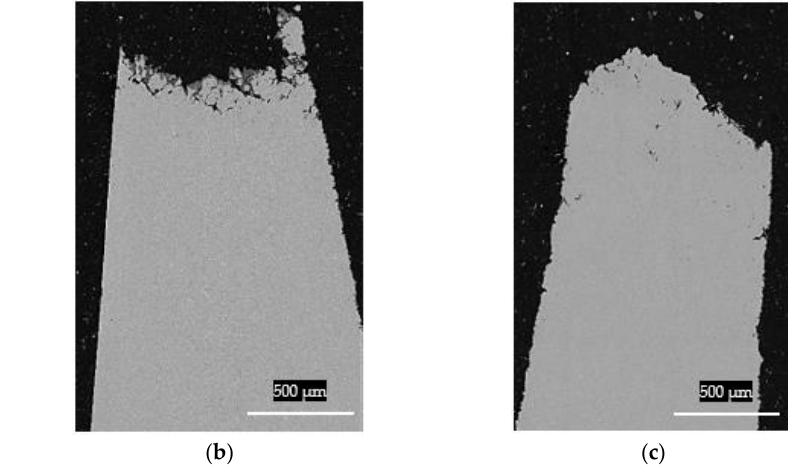
Figure 9. SEM post-creep; ( a ) TNM-0.8B-HIP, ( b ) TNM-0.8B-HIP-HT, ( c ) TNM-1.5B-IHT.